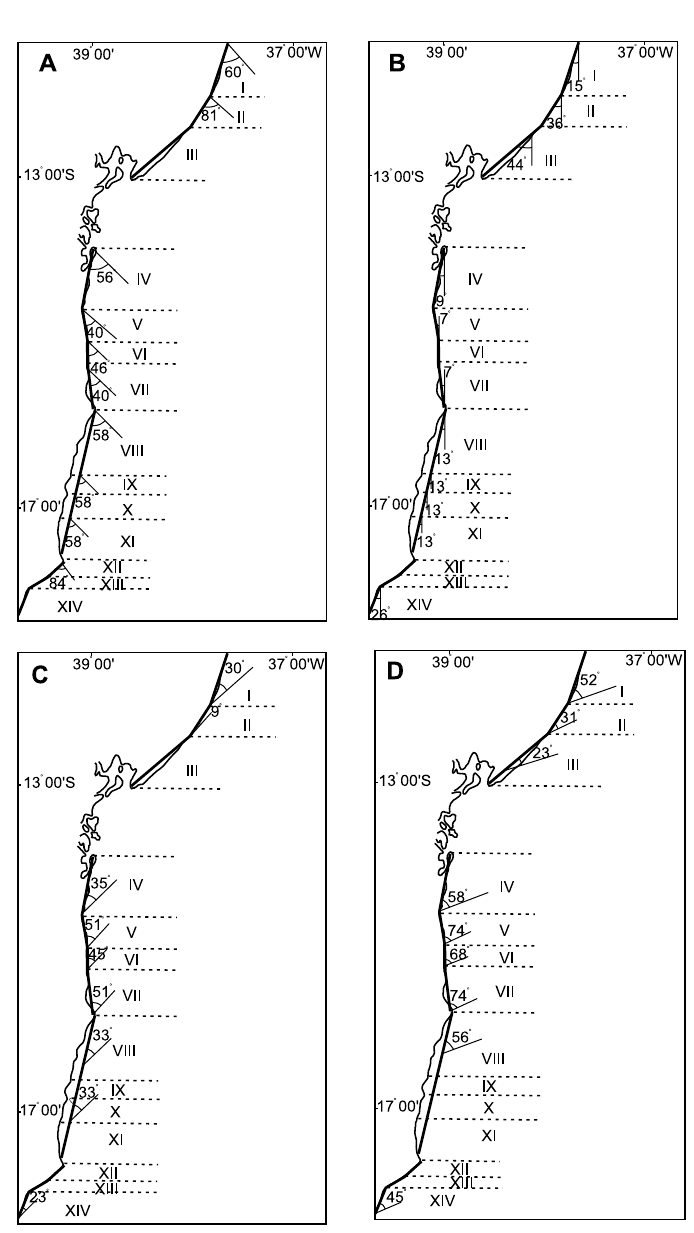
Fig. 5 – Angles of incidence formed by wave-fronts arising from the NE (N45 ◦ ) (A), E (N90 ◦ ) (B), SE (N135 ◦ ) (C) and SSE (N157.5 ◦ ) (D), in rela- tion to the different directions shown by the coastline of the State of Bahia, represented here by several segments. There was no incidence of waves from the NE (A) in Segments III, X, XIII and XIV (See Fig. 4A), from the E (B), in Segments XII and XIII (See Fig. 4B), from the SE (C), in Segments IX, XI and XII (See Fig 3A), and from the SSE (D), in Segments IX, XI and XV (See Fig. 3B). The angle of incidence is almost zero in the Segments VI (B), III and XIII (C) and XII and XIII (D).